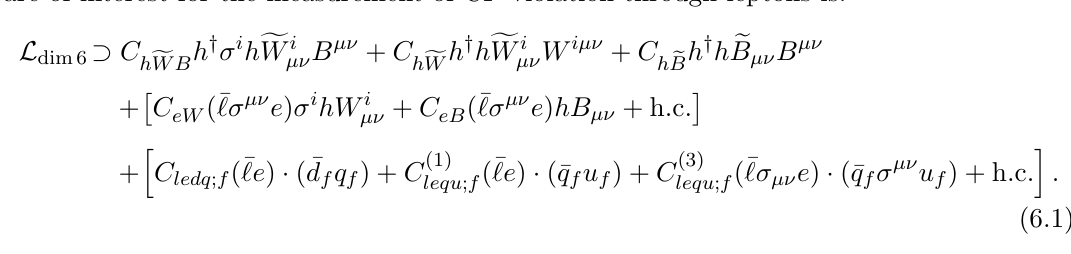
Figure 7 . The implication of the EDM bound in the ACME II experiment on the stop parameter space in the MSSM where the 125 GeV Higgs mass is realized by stop loops with a large A -term. The horizontal axis is the common stop mass m stop = m and m A in the left and right panels respectively. We (cid:12)x m A = 400 GeV in the left panel and tan (cid:12) = 10 in the right panel. The phase is taken to be arg( A t (cid:22) ) = (cid:25)= 2 ; (cid:25)= 8 ; (cid:25)= 32. The parameter (cid:22) is 350 GeV. The green region is excluded by the small Higgs mass with any values of the A -term. j j The blue curves denote the ACME II constraint. The green dotted curve describes the degree of (cid:12)ne-tuning de(cid:12)ned in